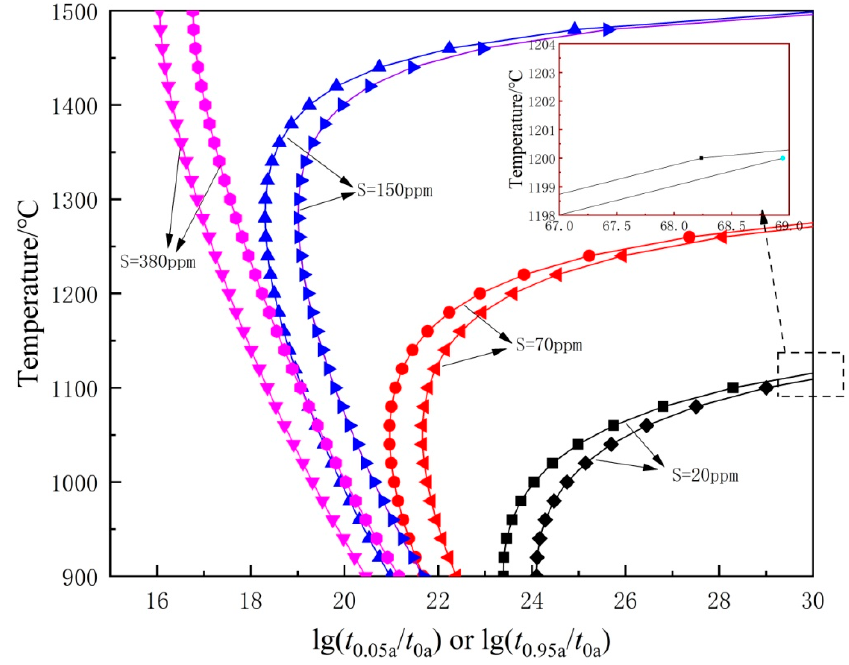
Figure 12. Curves for starting and completion of precipitation of MnS with different S contents.